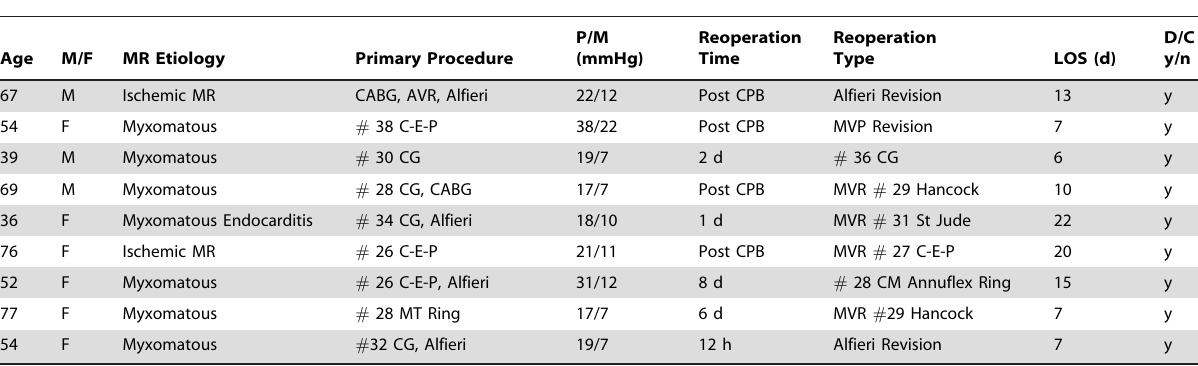
Table 2. Characteristics of Patients with Mitral Stenosis after Mitral Valve